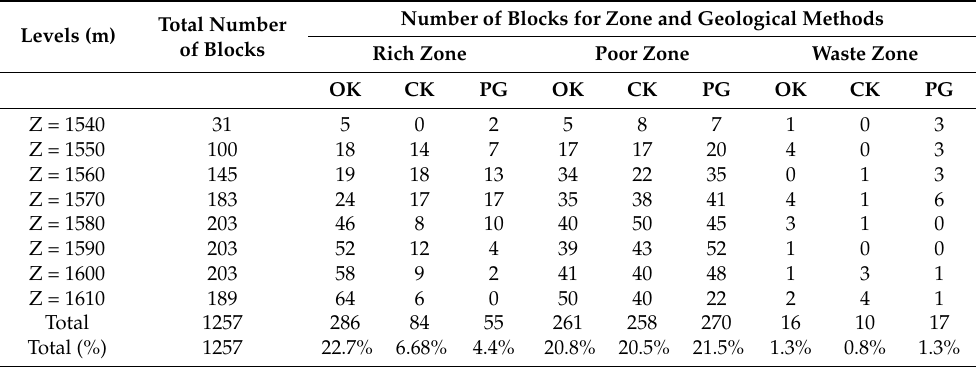
Table 7. Quantification of the optimal use of the estimation method in the case